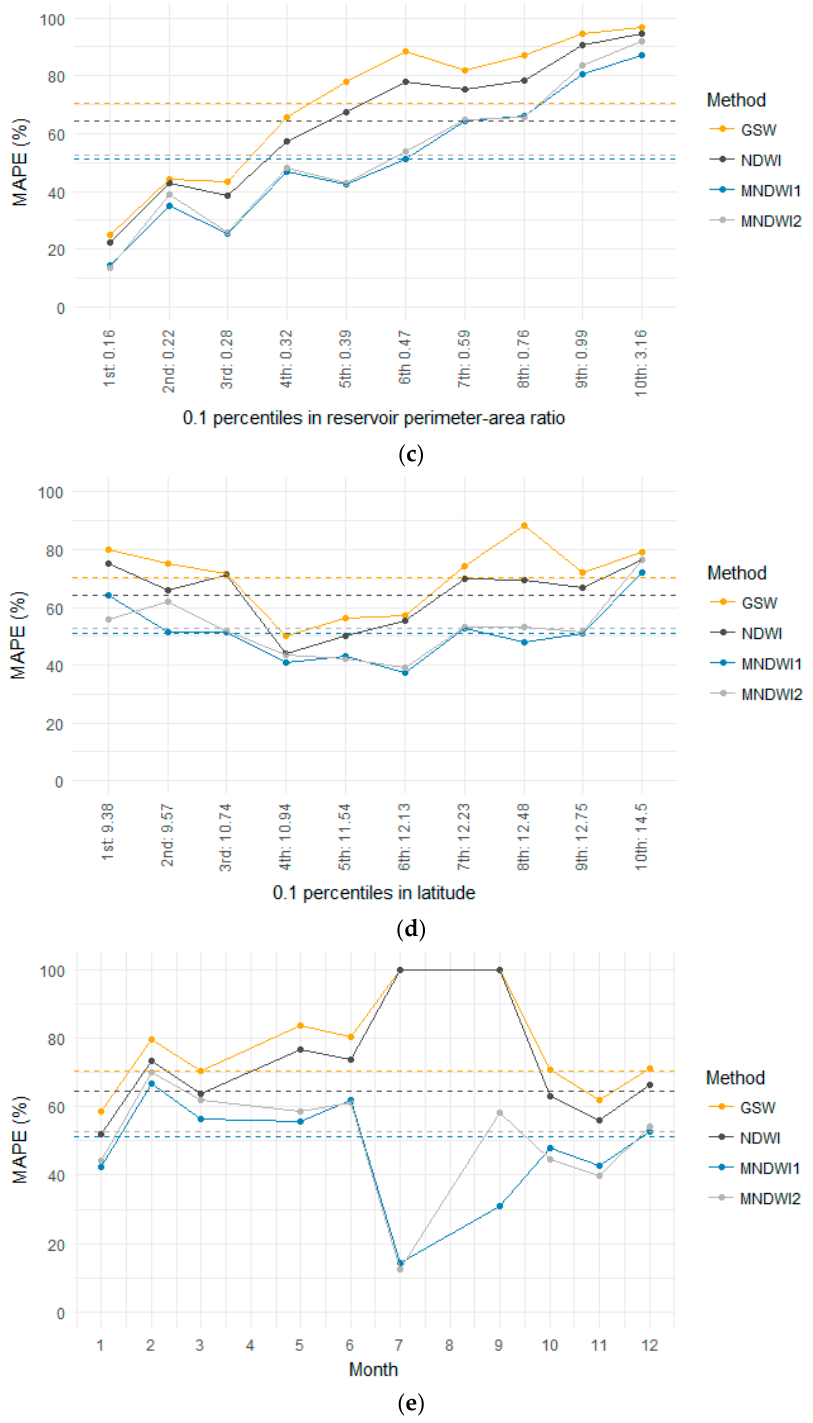
Figure 3. MAPE in reservoir area estimates derived from the four water classification methods (GSW, NDWI, MNDWI1, MNDWI2) when validation reservoirs are stratified by ( a ) mean NDVI, ( b ) reservoir area, ( c ) perimeter-area ratio, ( d ) latitude, and ( e ) month. Dashed lines indicate the overall MAPE corresponding to each method.